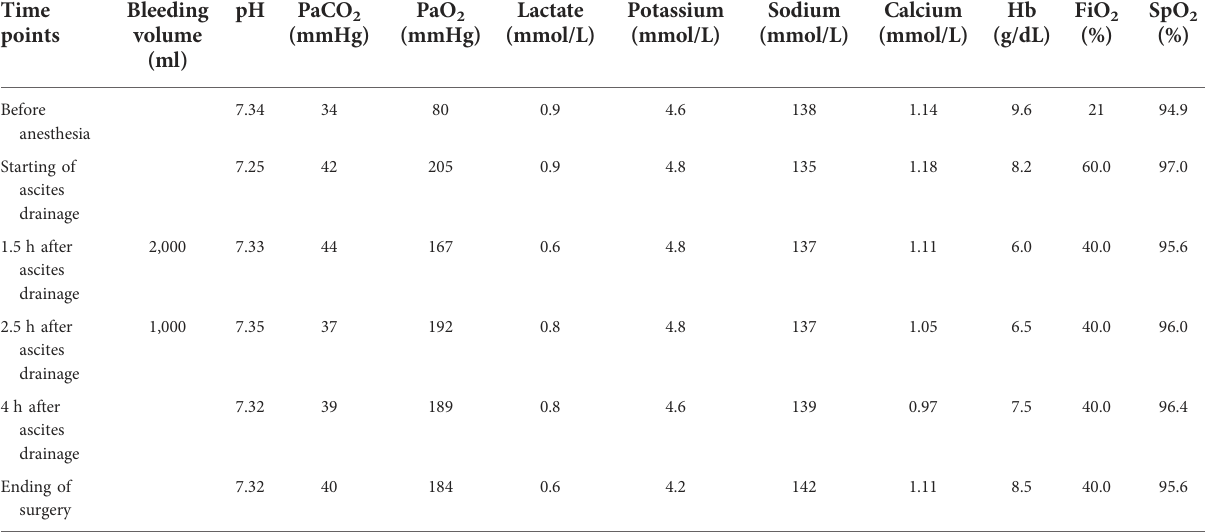
TABLE 1 Blood gas analysis at different periods during operation time.